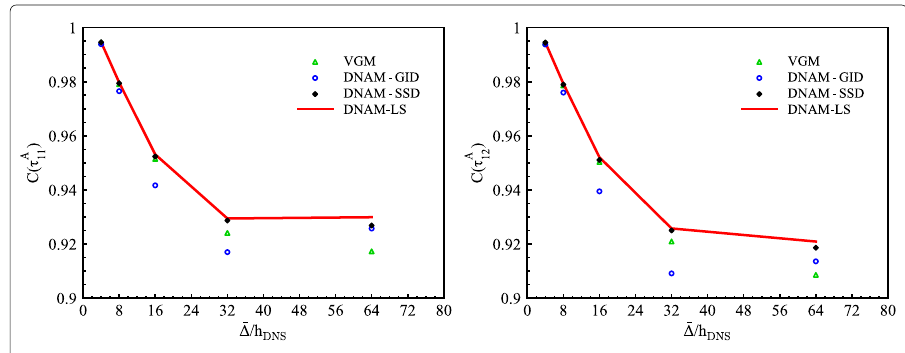
Fig. 2 Correlation coefficients of normal and shear SGS stresses in the apriori study